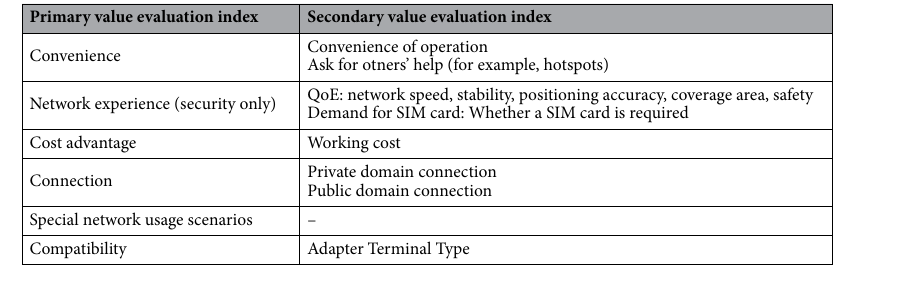
Table 2. Definition of the user value proposition evaluation.